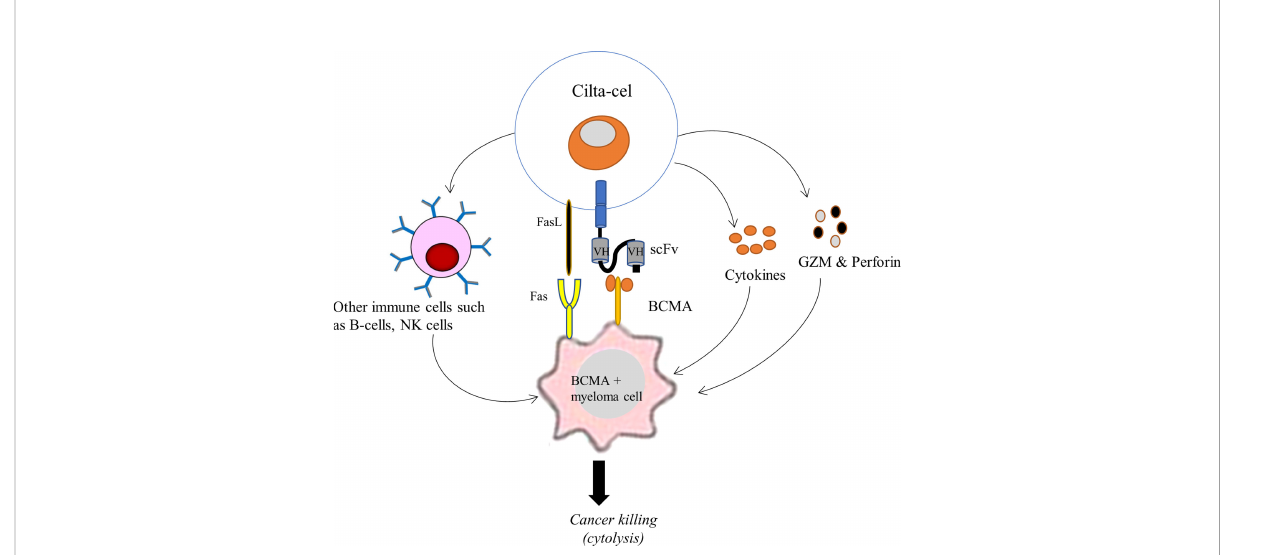
FIGURE 3 Schematic illustration of the mechanism of action of cilta-cel against BCMA expressing MM. Cilta-cel produces pro-in fl ammatory cytokines and recruits other immune cells (such as NK cells and B-cells) to the tumor site and induces in fl ammation that destroys myeloma cells. It also mediates the cytolysis of cancer cells by using an apoptosis-inducing perforin-granzyme system and Fas-FasL-axis. BCMA, B cell maturation antigen; FasL, Fas ligand; GZM, granzymes; NK cells, natural killer cells; VH, variable heavy